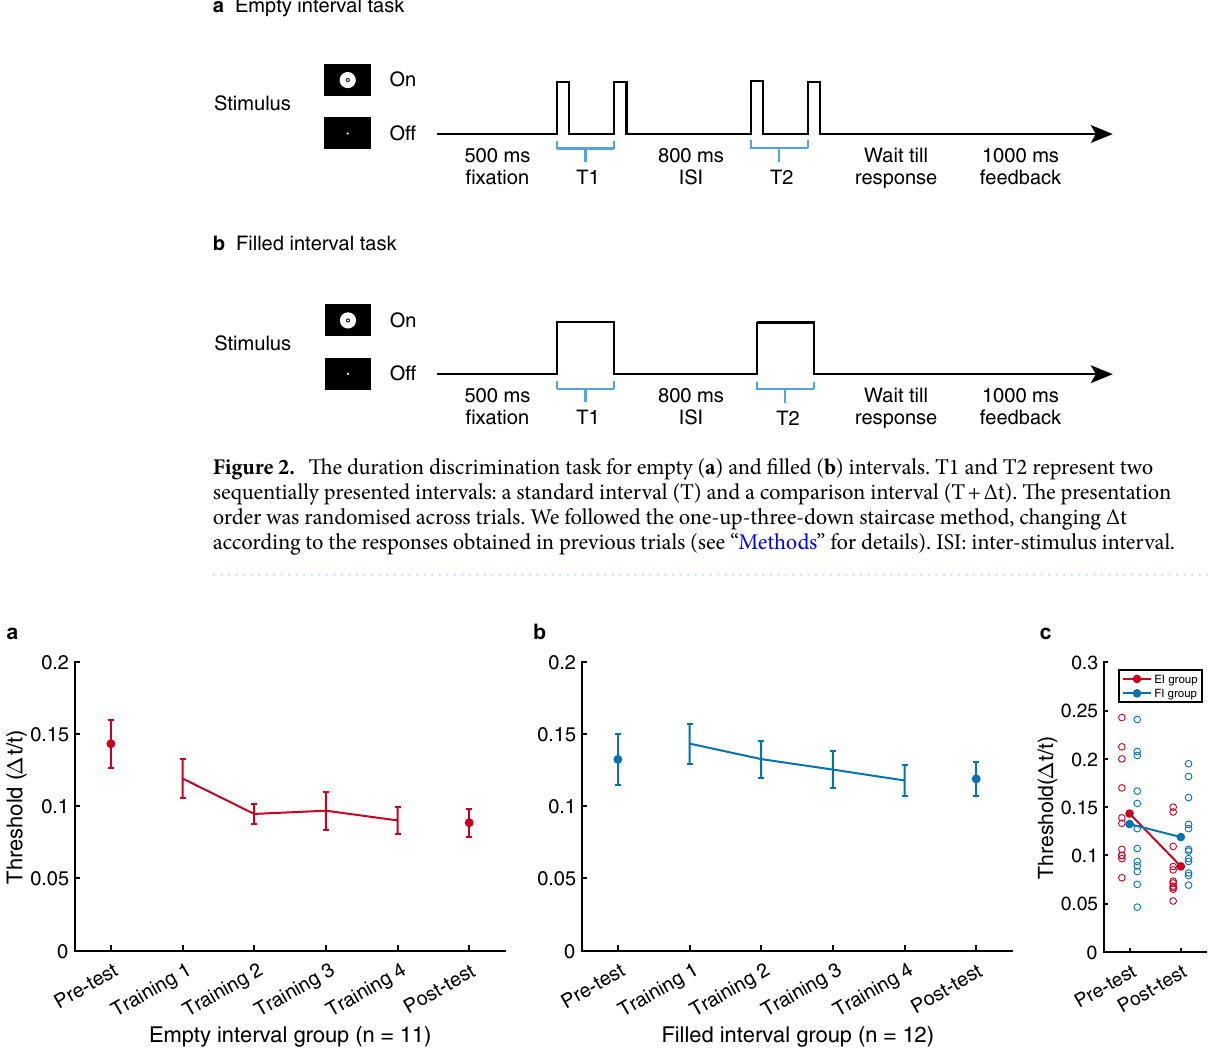
Figure 3. The learning effects of the empty-interval (EI) group ( a ) and the filled-interval (FI) group ( b ). The learning curve shows the change from the pre-test in trained interval thresholds (empty-200 ms for the EI group, filled-200 ms for the FI group) across four training sessions and to the post-test. ( c ) used the same data on the left figures to compare the pre- and post-test mean thresholds of the two groups with individual thresholds presented by scattered points. Error bars indicate between-subject standard errors